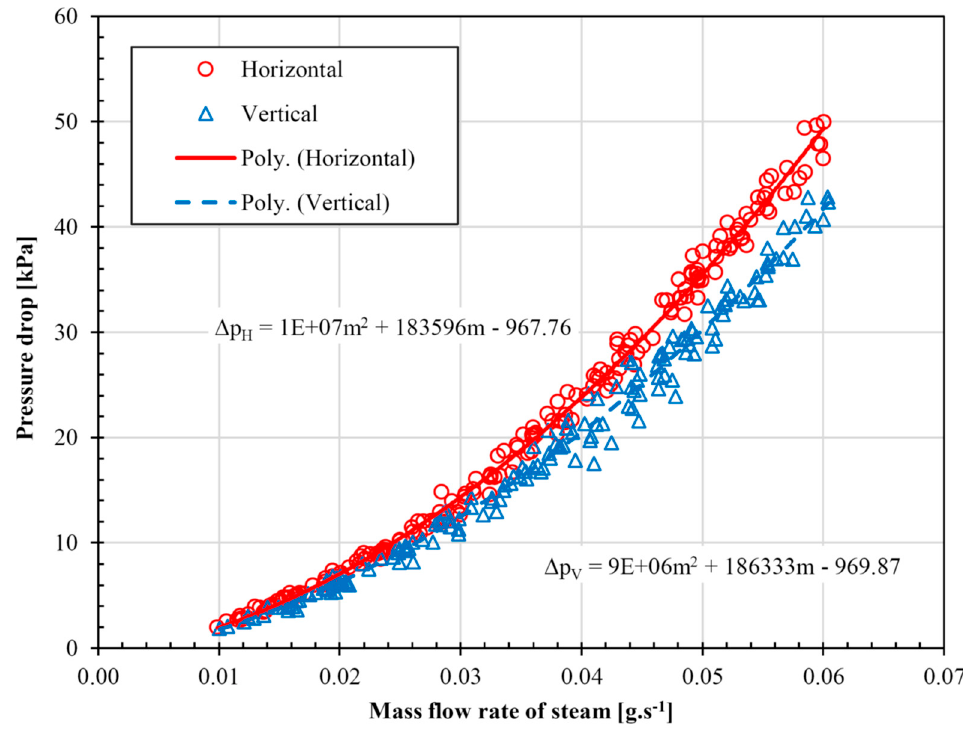
Figure 6. Comparison of pressure drops in the cases of horizontal and vertical microchannels.